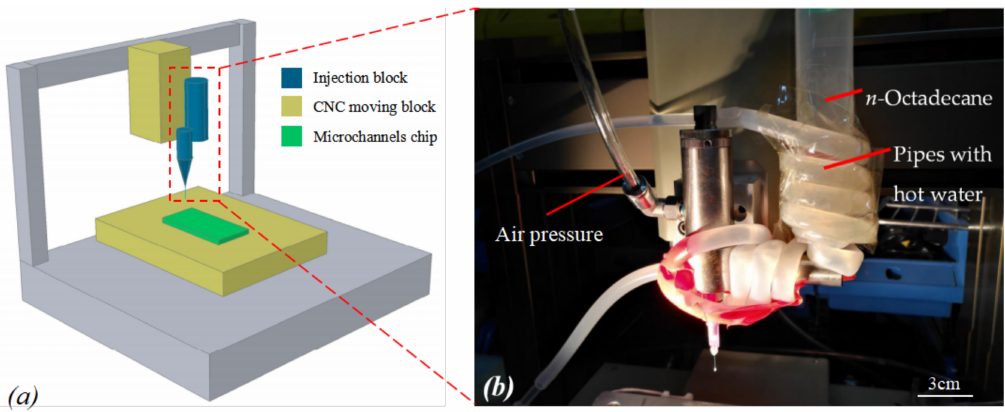
Figure 6. ( a ) The schematic diagram of phase-change material (PCM) injection system using a dispensing machine; ( b ) Close-up view of the injection needle and the container for PCM.